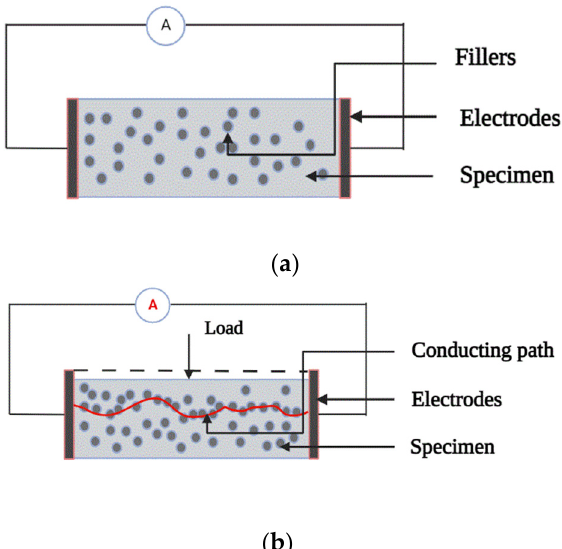
Figure 3. ( a ) Two-probe specimen setup. ( b ) Piezoresistive behaviour of the specimen under the loading condition.